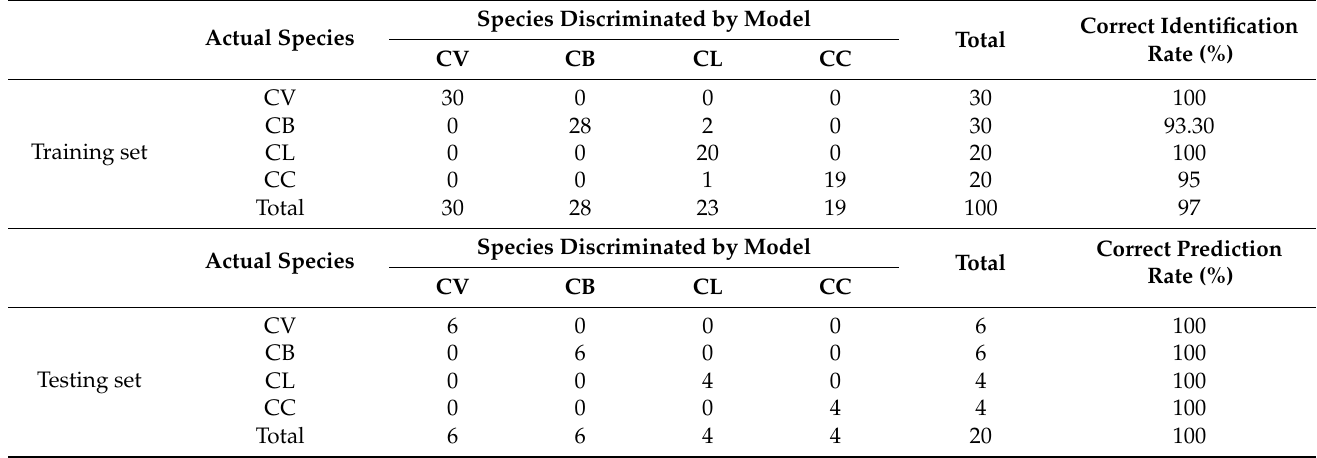
Table 2. Correct identification and prediction rates of the training and testing sets based on the MDA model. Species Discriminated by Model Actual Species